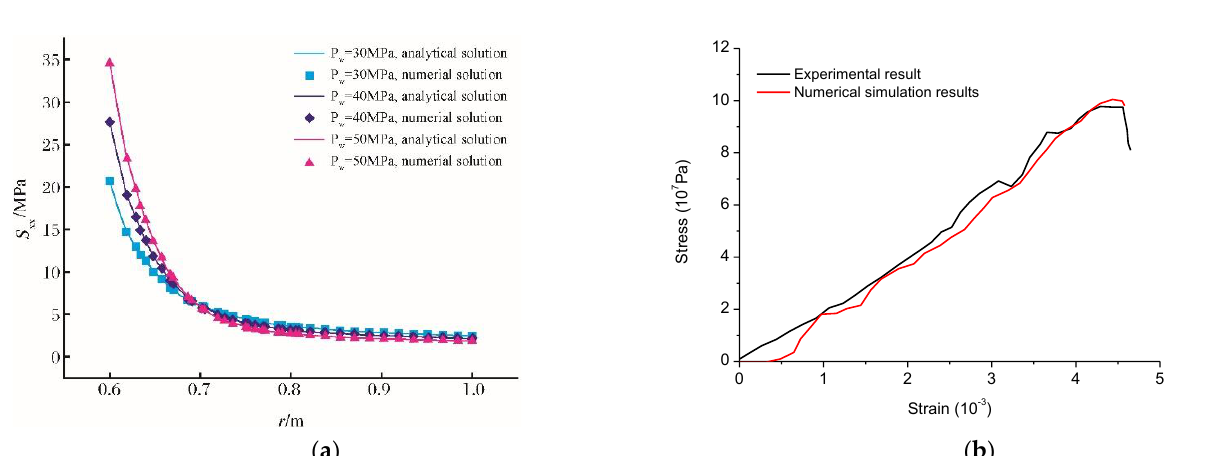
Figure 1. Validation examples: ( a ) numerical solution and analytical solution of S xx stress component; ( b ) comparison of numerical simulation and experimental results. Table 1. Input parameters.